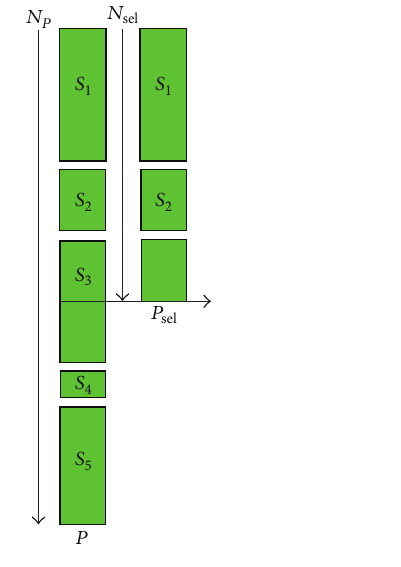
Figure 2: NSGA-II